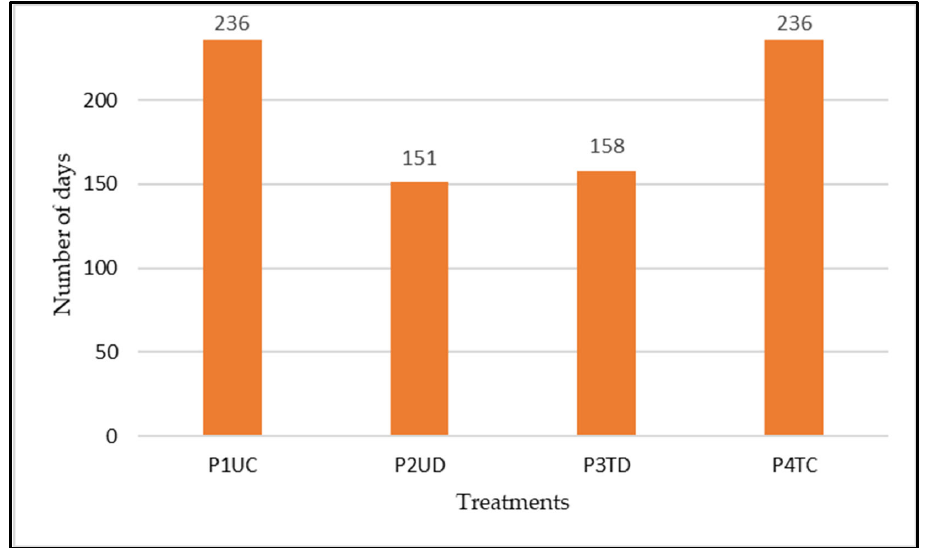
Figure 7. Total grazing days in each